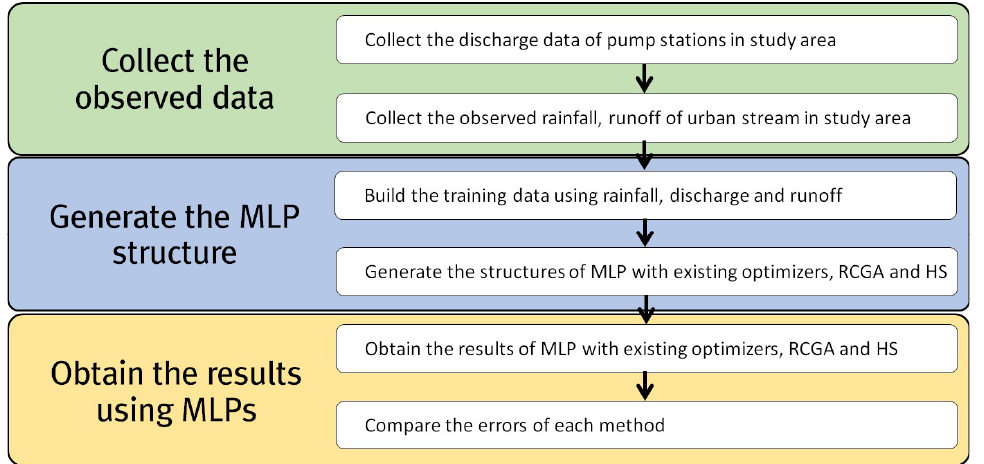
Figure 1. Application process followed to predict the runoff of urban stream.